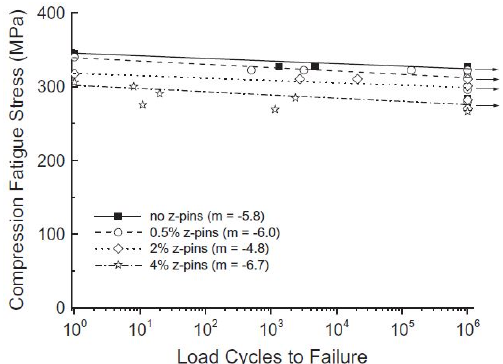
Figure 48. S-N curve for z-Pinned composite subjected to cyclic compression-compression (CFRP z-Pins, d = 0.28 mm, [0] pre-preg) [1].